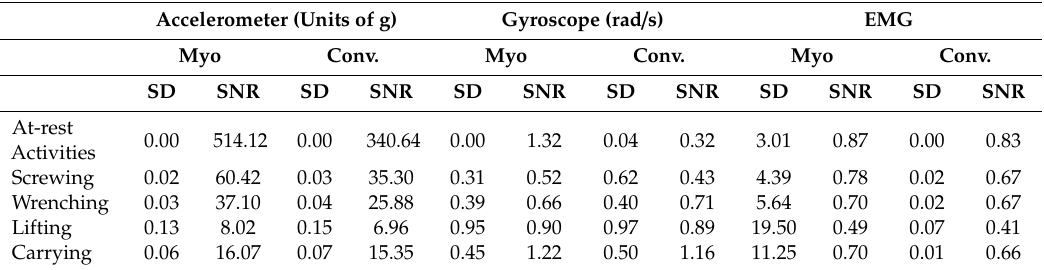
Table 1. Comparison of EMG and IMU data quality of Myo armband and conventional sensors. Accelerometer (Units of g) Gyroscope (rad / s) EMG